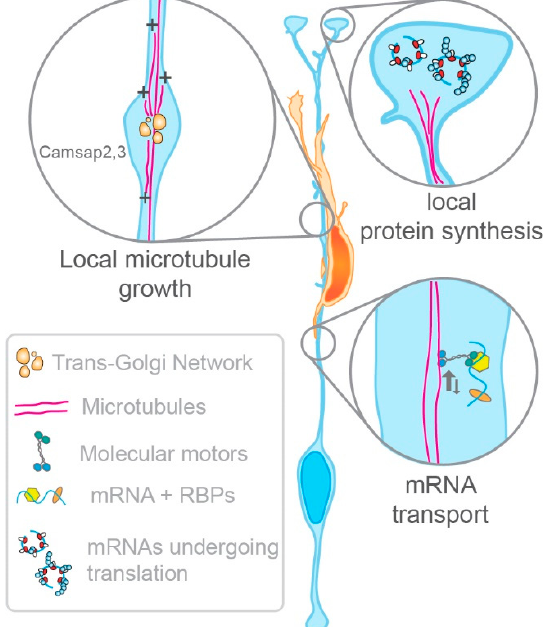
Figure 4. Basic mechanisms involved in the regulation of the morphology of the basal process. Left: A microtubule network regulates the radial glial basal process morphology and thus facilitates radial migration. Microtubule nucleation occurs locally within the radial glia basal process. Known proteins that help in the nucleation of microtubules are localized in varicosities containing Trans Golgi Network proteins as well as the minus-end binding proteins CAMSAP2 and CAMSAP3. Right: mRNAs regulating the shape of the radial glia basal are transported within the basal process and locally translated in the basal endfeet (RBP: RNA-Binding protein).